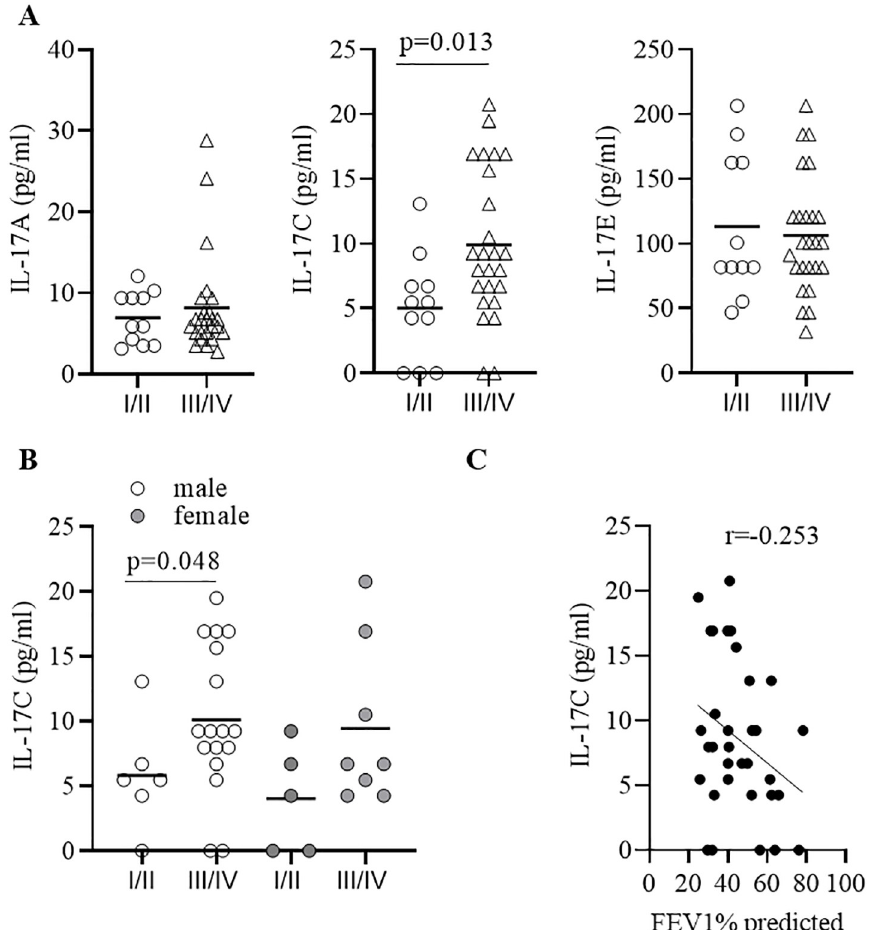
Fig 6. IL-17C concentrations are increased during advanced COPD. (A) Concentrations of IL-17A, IL-17C, and IL- 17E in sputum collected from GOLD I/II and GOLD III/IV COPD patients during AECOPD. (B) Concentrations of IL-17C in sputum separated in male (m) and female (f) donors. Horizontal lines indicate mean values. (C) Association of IL-17C concentrations with FEV1 (%) predicted. Correlation analysis was performed using nonparametric Spearman’s correlation test.